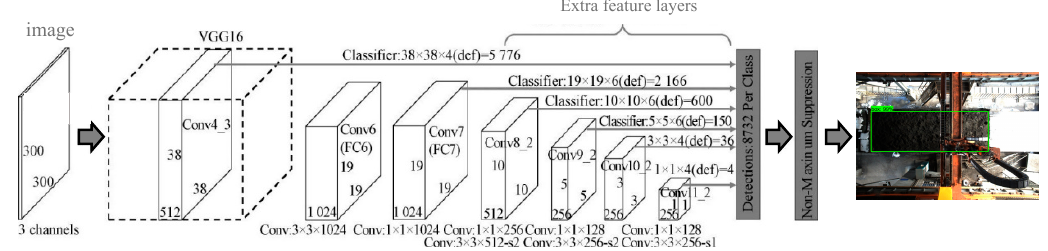
Figure 9. Framework of SSD.